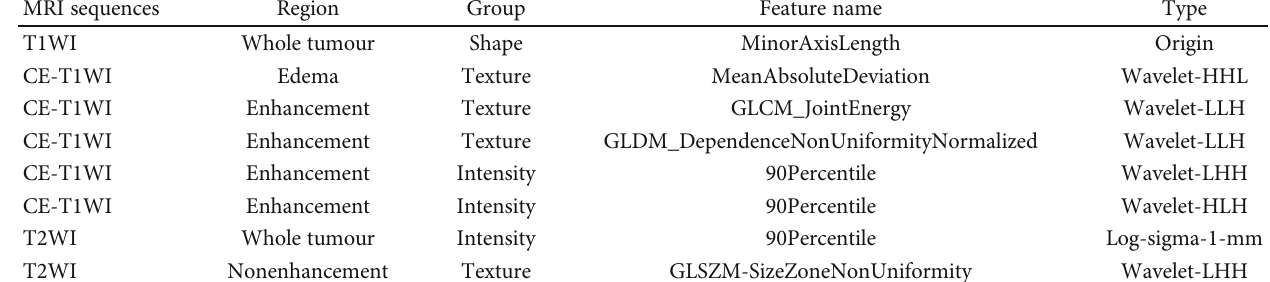
Table 2: A summary of the high-throughput radiomics features extracted.